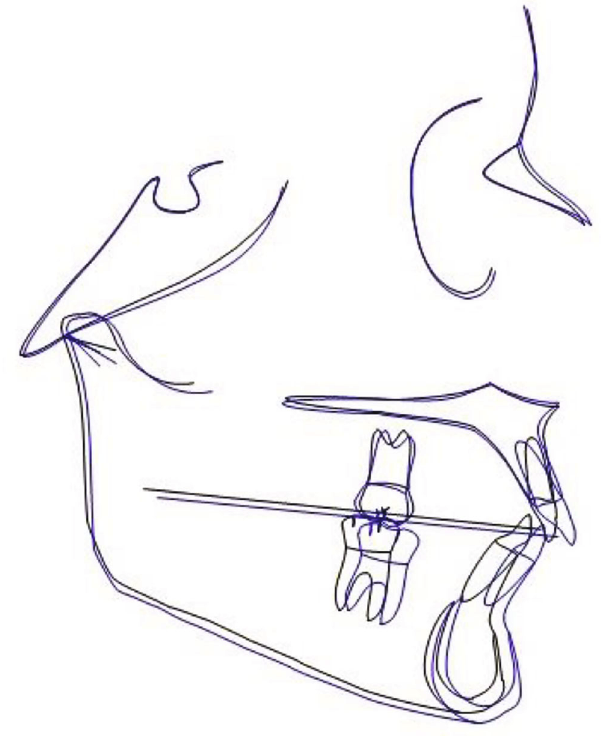
Table 6: Post-treatment Pancherz cephalometrics values.